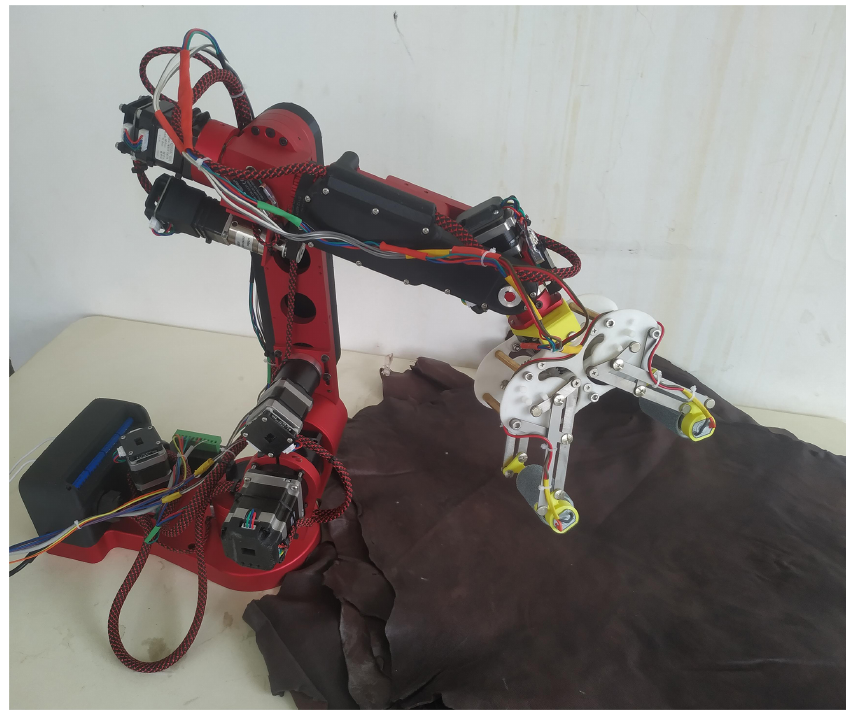
Figure 12. Actual prototype picture of the end effector.